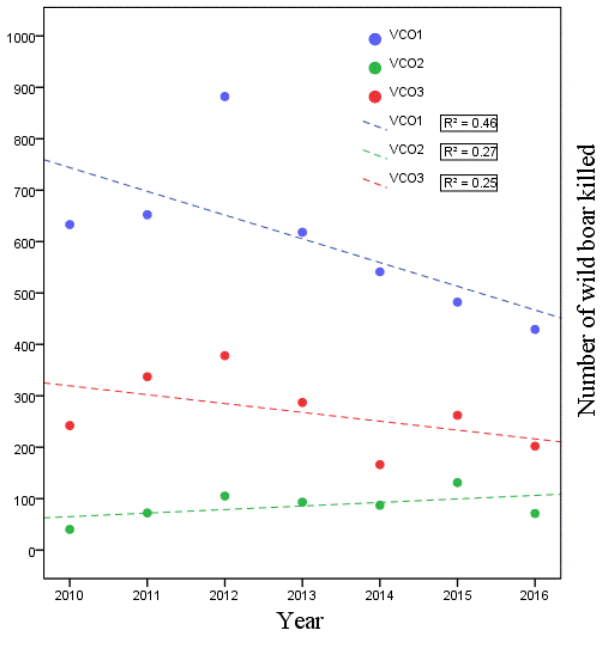
Fig. 5. Trend in the number of wild boar bagged over time from hunting activity and community empowerment activity in VCO1 and VCO3 hunting areas and from incidental take and community empowerment activity in VCO2 from 2010 to 2016. There is a decreasing trend in VCO1 and VCO3, and an inreasing trend in VCO2.